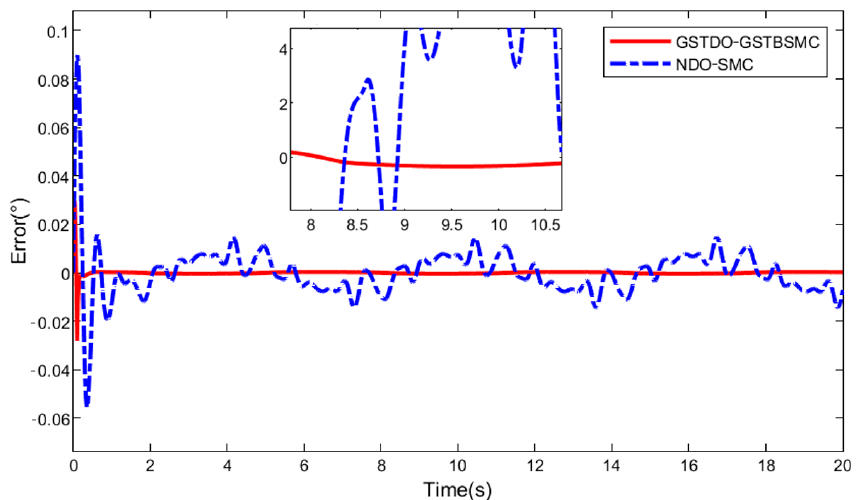
Figure 4. Comparison of the tracking error between GSTDO-GSTBSMC and NDO-SMC in Experi- ment 1.